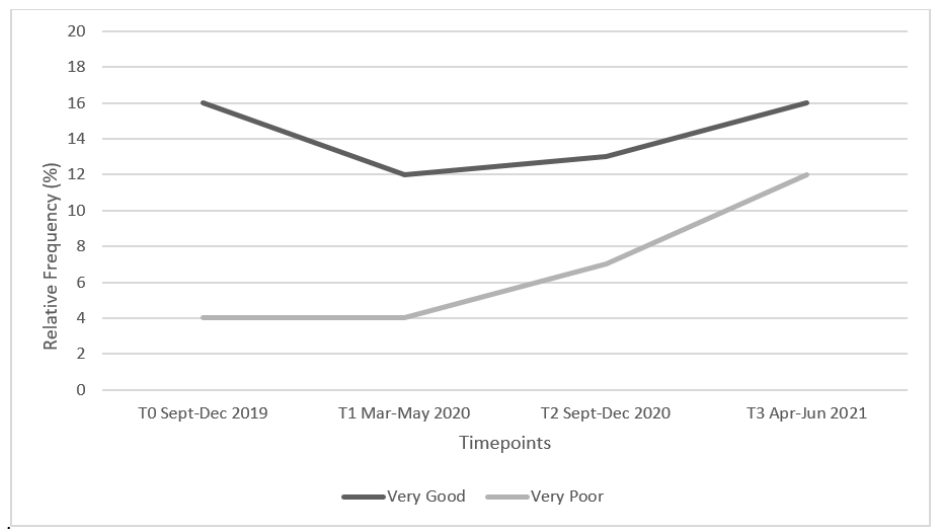
Figure 4. Percentage of participants who rated their sleep quality as ‘Very Good’ or ‘Very Poor’ at the four timepoints during COVID-19